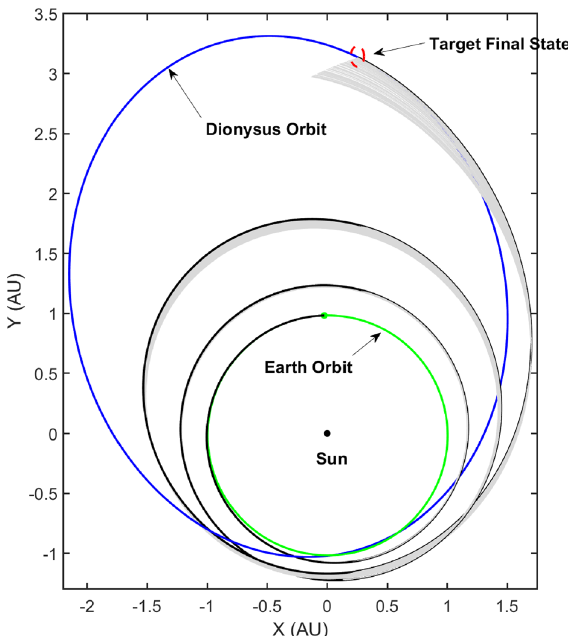
Figure 5. 5% knockdown bundle of non-optimal trajectories.